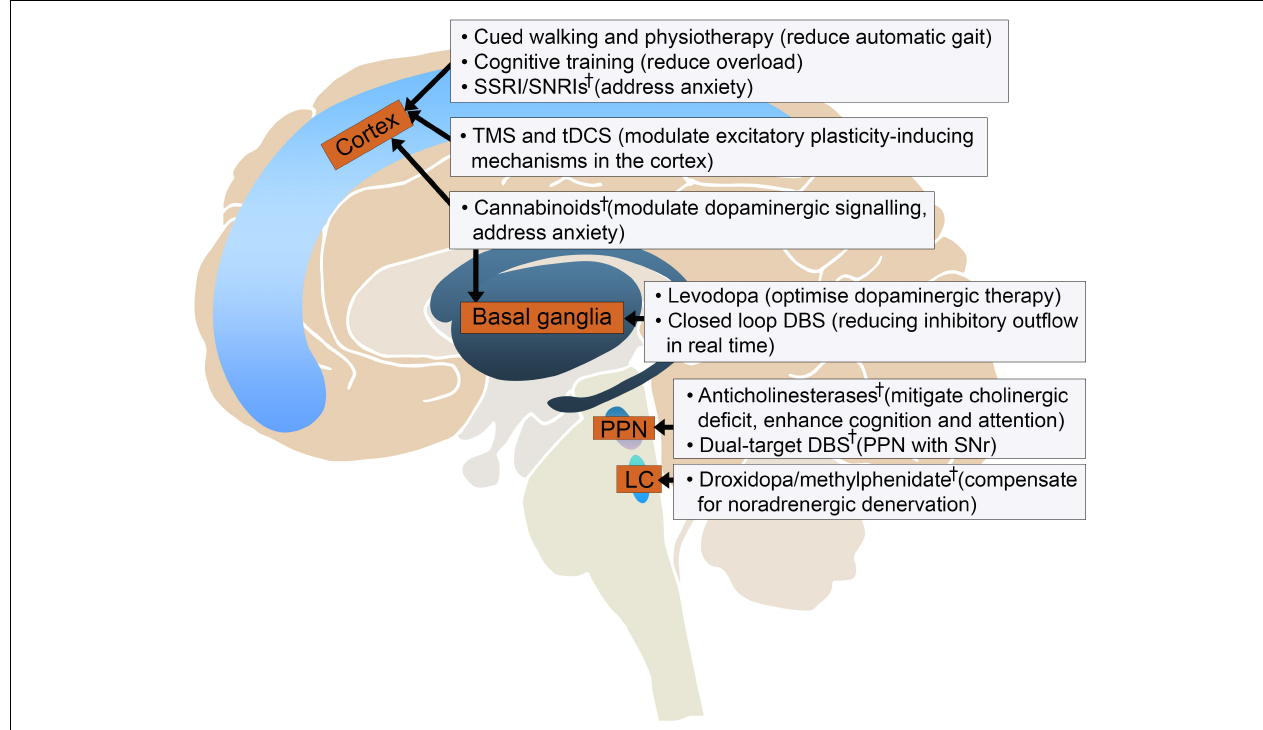
FIGURE 2 | Current and experimental † developments in treating gait freezing based on their potential targets in the locomotor circuit. DBS, deep brain stimulation; LC, locus coeruleus; PPN, pedunculopontine nucleus; SNr, substantia nigra pars reticulata; SSRI/SNRI, selective serotonin reuptake inhibitor/serotonin noradrenaline reuptake inhibitor; tDCS, transcranial direct current stimulation; TMS, transcranial magnetic